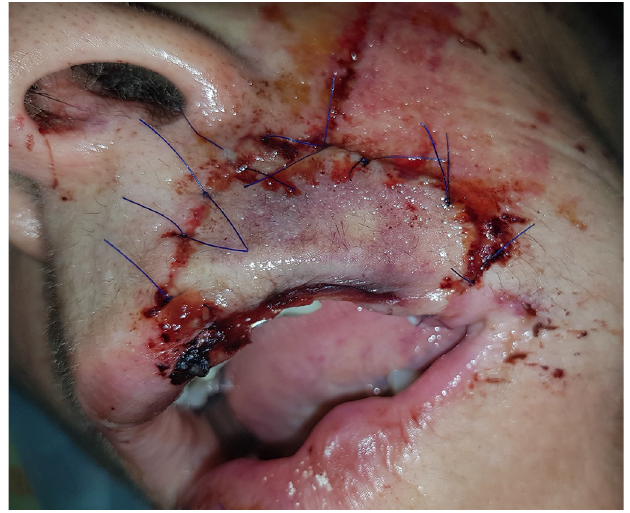
Fig. 1. Atday0,aspect of the lesionaftersuture of the torn lip portion.